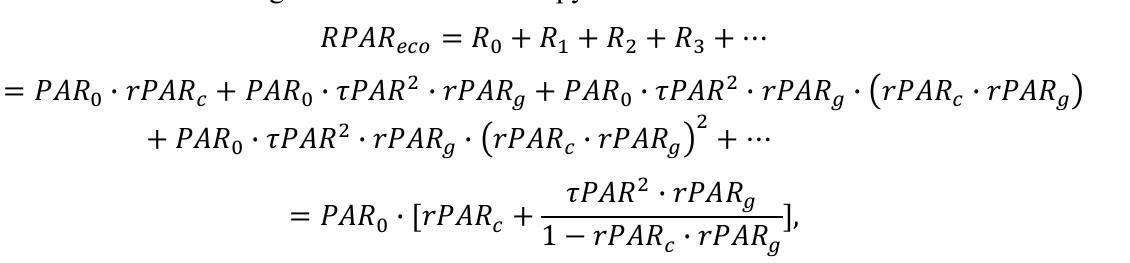
Figure A2. Simplified canopy model with multiple reflection and transmission of PAR. R